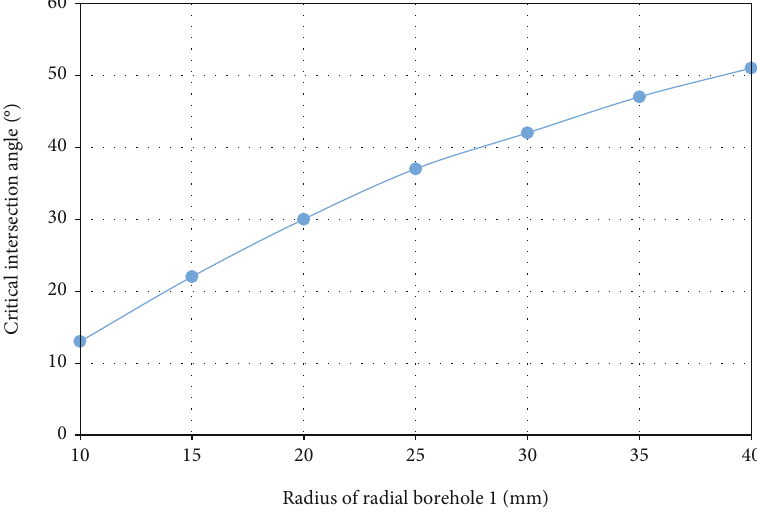
Figure 14: Critical intersection angle with di ff erent radius of radial borehole